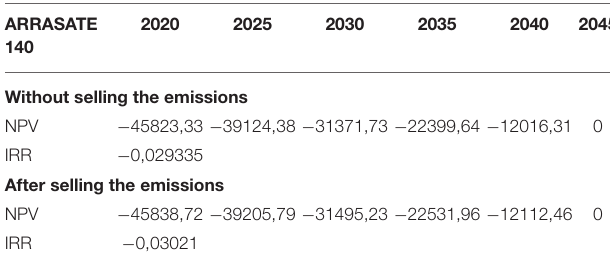
TABLE 2 | NPV and IRR for the installation of the solar thermal system in ZABALGANA 92.